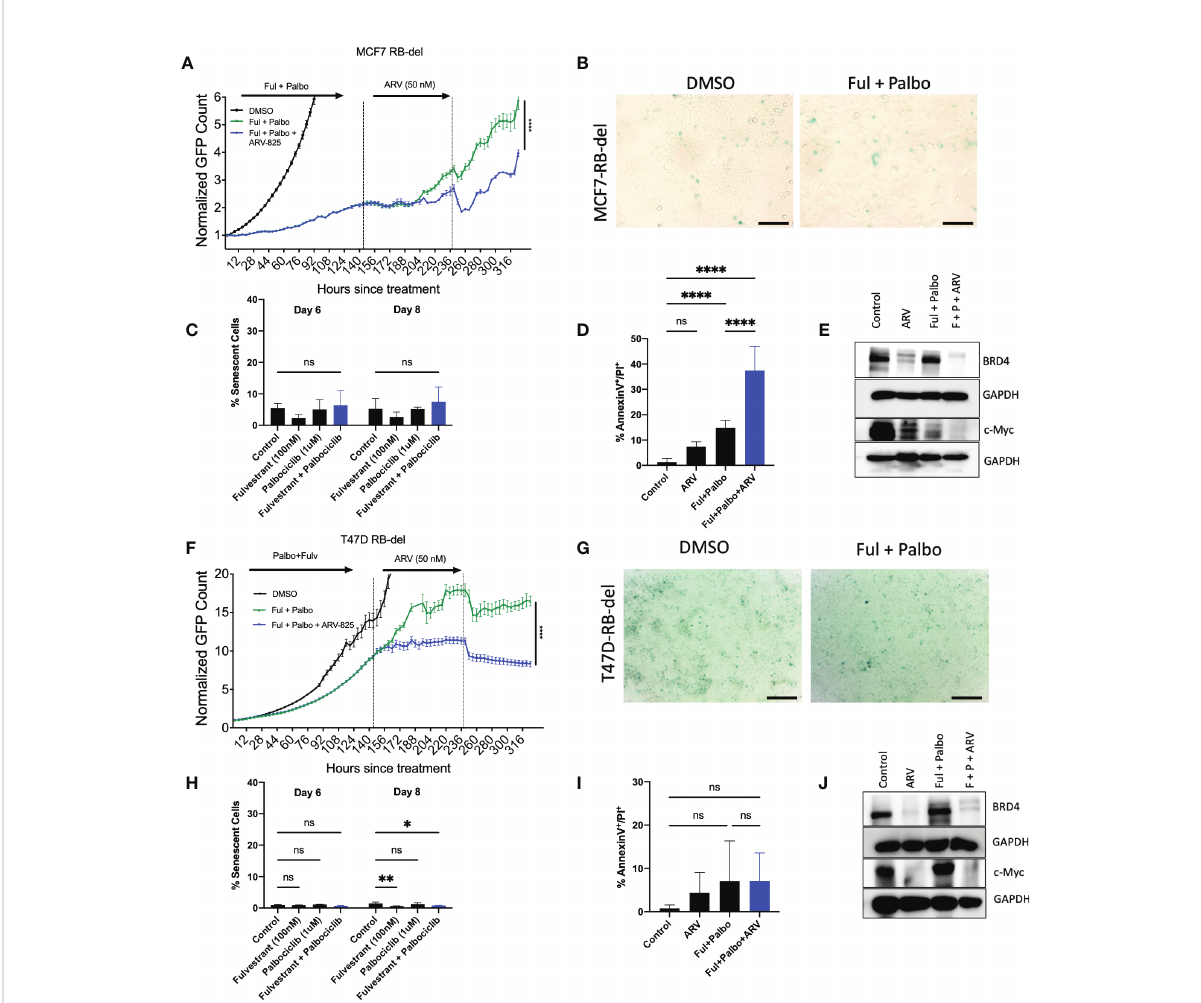
FIGURE 7 ARV-825 prolongs growth arrest induced by the combination of Fulvestrant and Palbociclib in resistant MCF-7 and T47D cells. Live cell imaging in MCF-7 Rb-del cells that were treated with palbociclib (1 µM) in combination with fulvestrant (100 nM) for 6 days. (A) Live cell viability of Rb- de fi cient MCF-7 cells was monitored via IncuCyte over a period of 14 days and normalized to GFP count. (B) MCF-7 Rb deleted cells were fi xed on Day 6, stained with x-gal staining solution, and imaged using bright fi eld microscope. All images were taken with the same magni fi cation. (C) Quanti fi cation of SA-Beta gal using C12FDG at indicated timepoints. (D) Apoptosis was evaluated by fl ow cytometry using an APC Annexin V Apoptosis Detection Kit. (E) Western blotting for BRD4, c-Myc at day 4 of ARV treatment. (F) Live cell viability of Rb-de fi cient T47D cells was monitored via IncuCyte over a period of 14 days and normalized to GFP count. (G) Cells were fi xed on Day 6, stained with x-gal staining solution, and imaged using bright fi eld microscope. All images were taken with the same magni fi cation. (H) Quanti fi cation of SA-Beta gal using C 12 FDG at indicated timepoints. (I) Apoptosis was evaluated by fl ow cytometry using an APC Annexin V Apoptosis Detection Kit. (J) Western blotting for BRD4, c-Myc at day 4 of ARV treatment. *P ≤ 0.05, **P ≤ 0.01, ****P ≤ 0.0001, ns (not signi fi cant) indicate statistical signi fi cance of each condition compared to control as determined using two ‐ way ANOVA with Sidak's post hoc test. All images are representative fi elds, blots, or data from two independent experiments ( n =